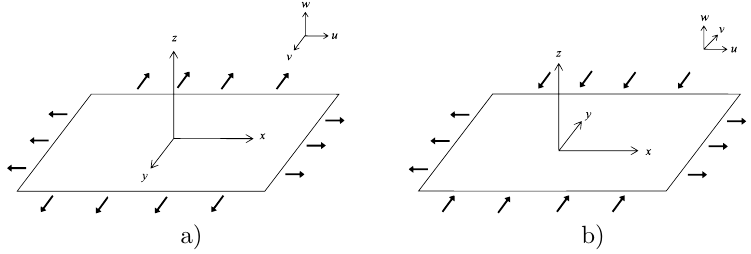
Figure 1. Physical model and co-ordinate system: a) stretching surface, b) shrinking